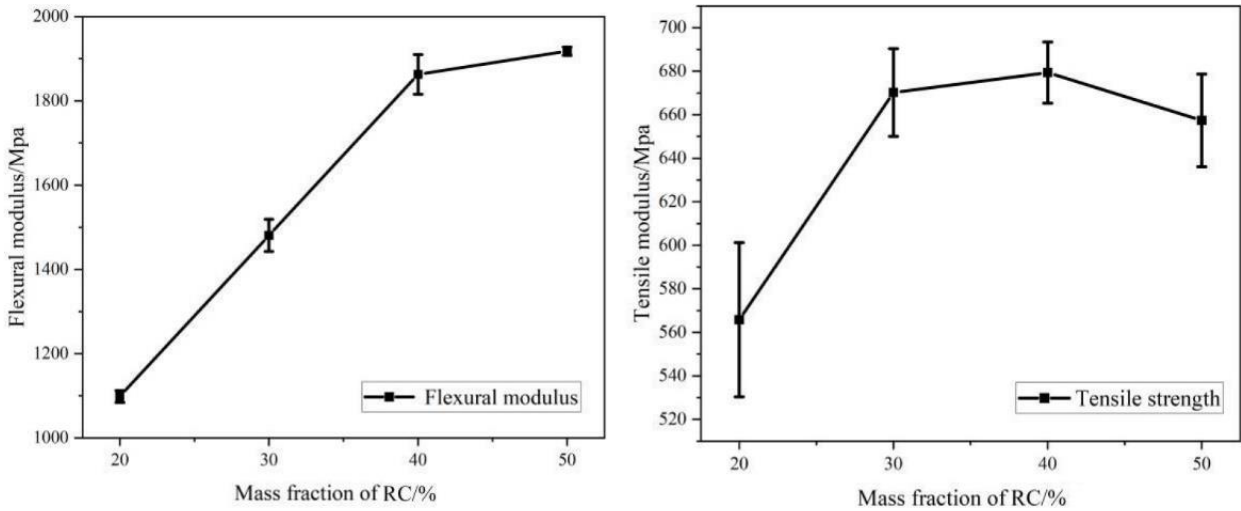
Figure 1. Tensile and flexural properties of RC/PP Composites.